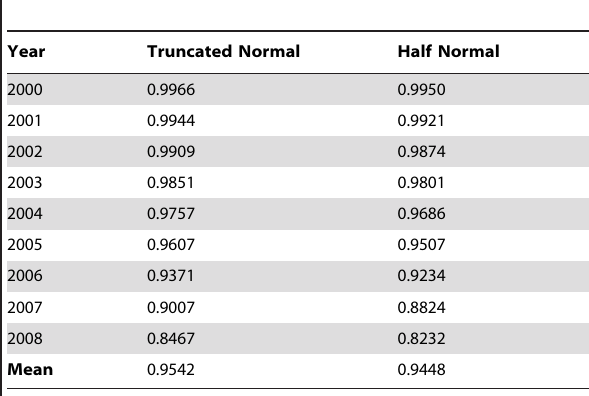
Table 4. Year-wise Average Efficiency of Companies in Dhaka Stock Exchange by distribution with